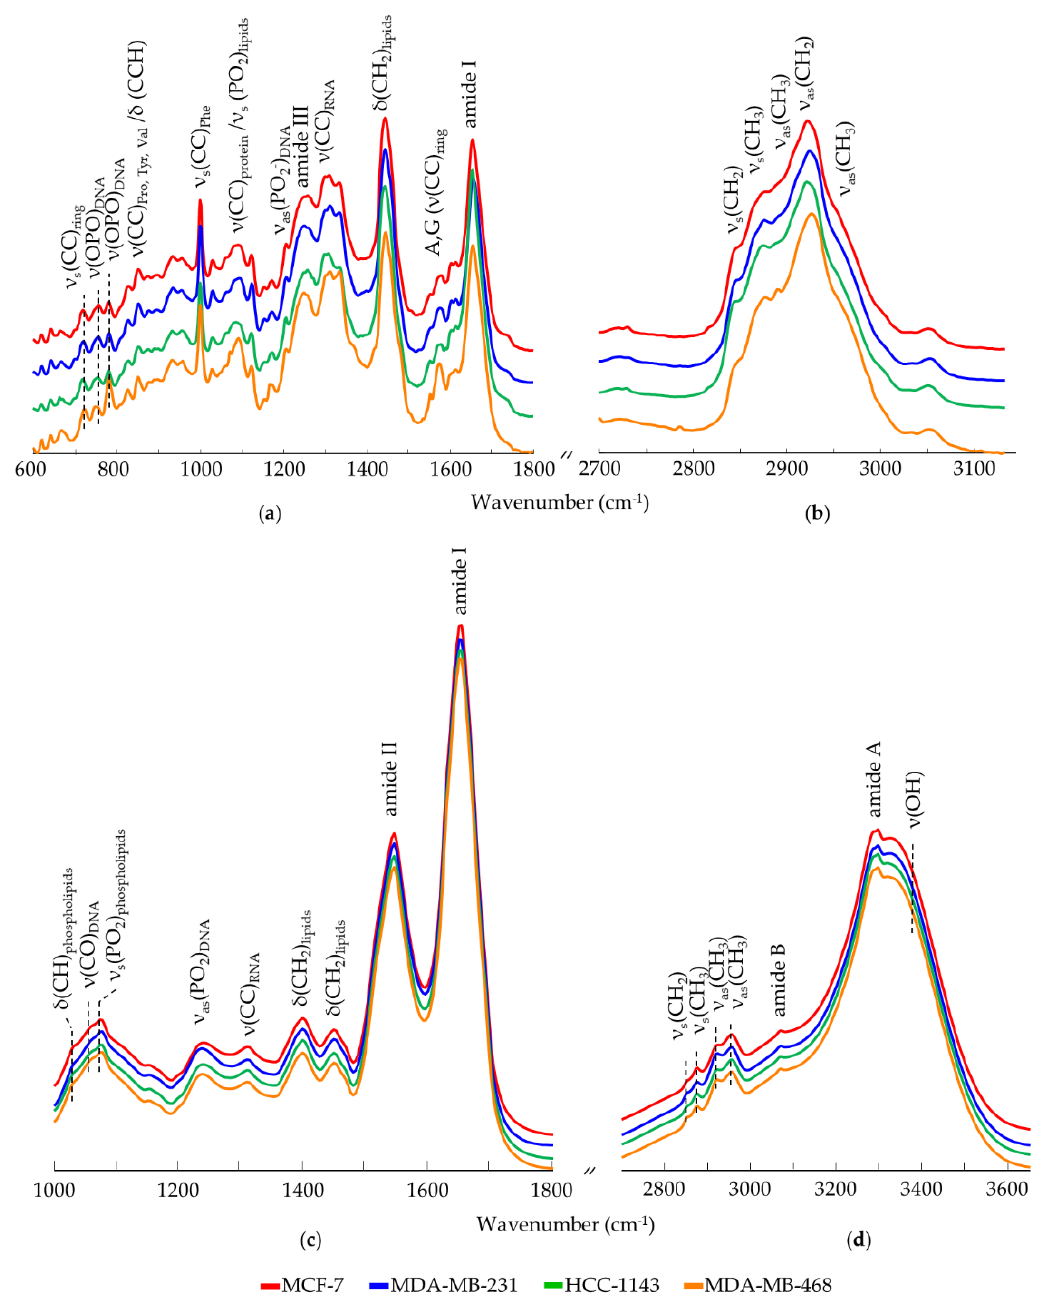
Figure 1. Mean Raman spectra (600–1800 cm − 1 and 2700–3140 cm − 1 , ( a , b ) and mean FTIR spectra (1000–1800 cm − 1 and 2700–3650 cm − 1 , ( c , d )) for the human breast cancer cell lines MDA-MB-231, MDA-MB-468, HCC-1143 and MCF-7. ( δ —deformation; ν —stretching; s—symmetric; as—anti- symmetric. Phe—phenylalanine; Pro—proline; Tyr—tyrosine; Val—valine. For clarity’s sake, the mean spectra are offset along the y-axes).